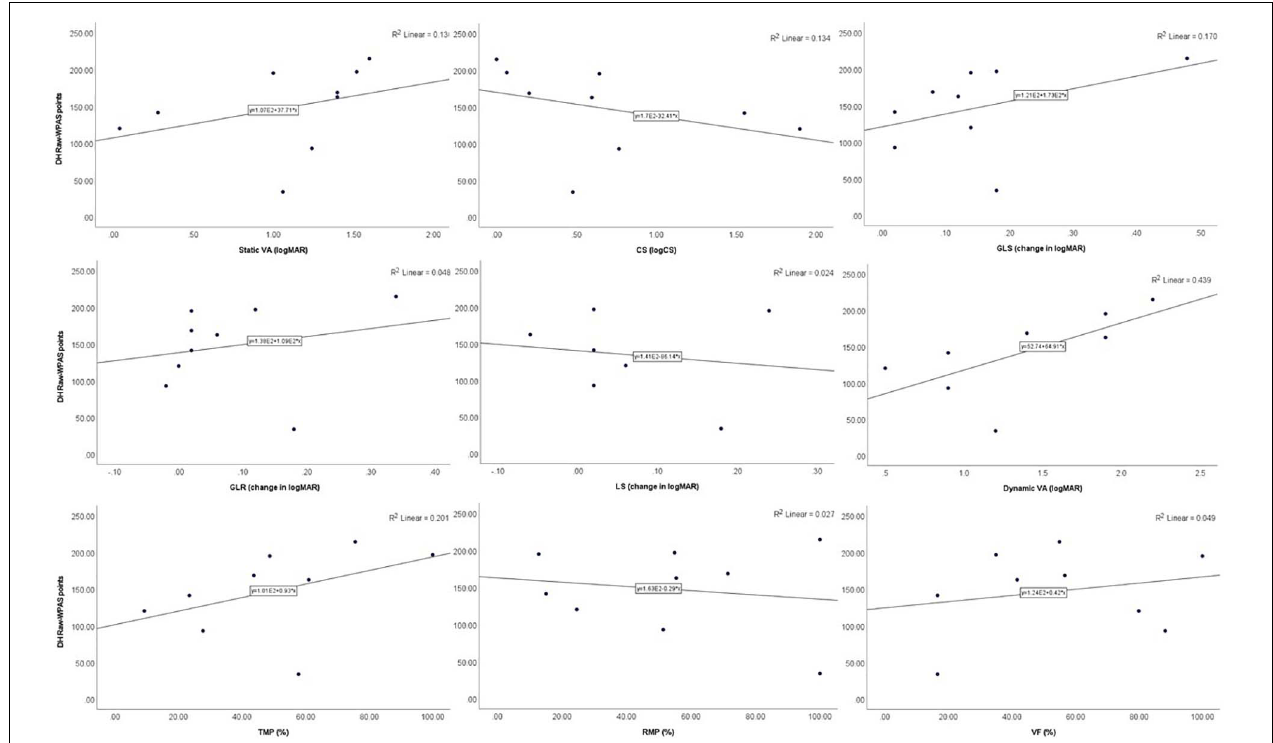
FIGURE 3 | Scatter plots showing the relationships between DH raw-WPAS points and visual